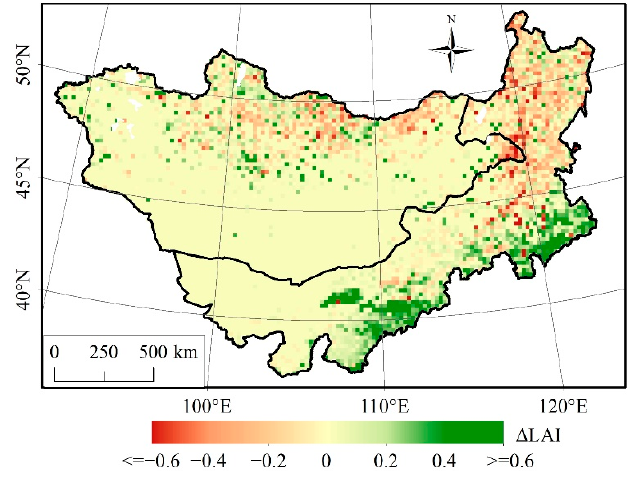
Figure 2. Changes in growing season LAI from the 1990s to the 2010s.